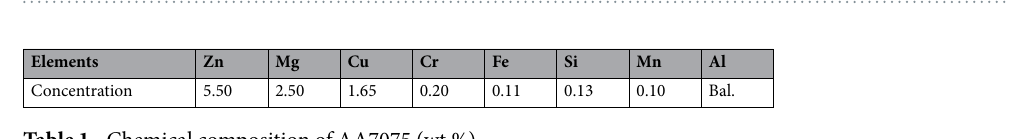
Figure 9. The schematic diagrams of solidification processes of AA7075 alloys. ( a ) Pure alloy; ( b ) nano-treated alloy with TiC NPs.